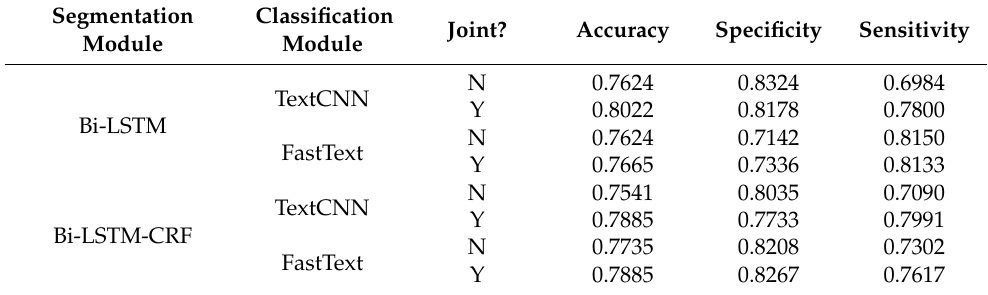
Table 6. Comparative experiments on different